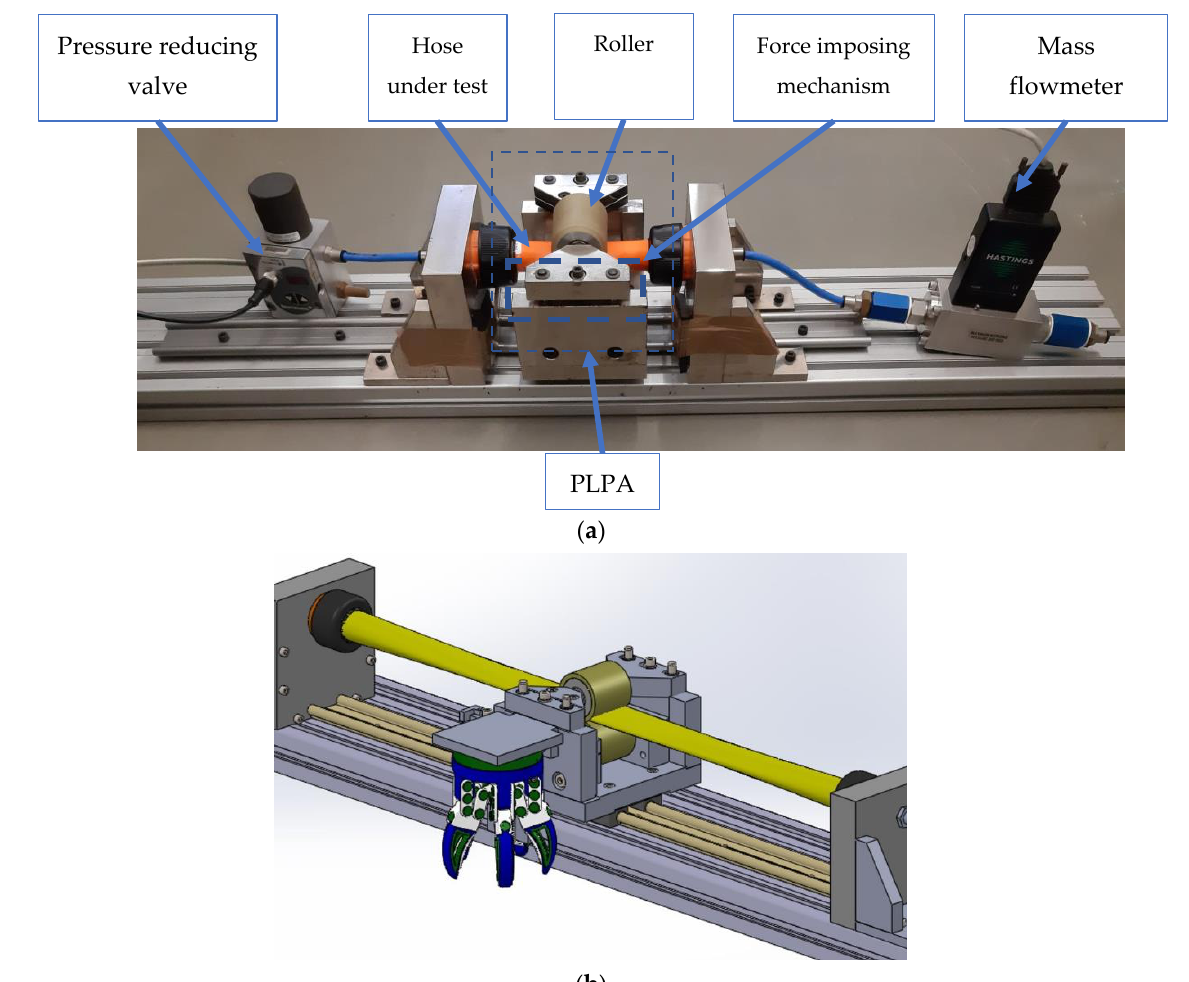
Figure 3. ( a ) Picture of the experimental setup; ( b ) 3D render including a gripper for pick and place operations. The back-and-forth motion of the carriage is obtained using the pneumatic circuit represented in Figure 4 where the solenoids of the valve are commanded to obtain an oscillating behaviour between the actuator stroke limits [12].